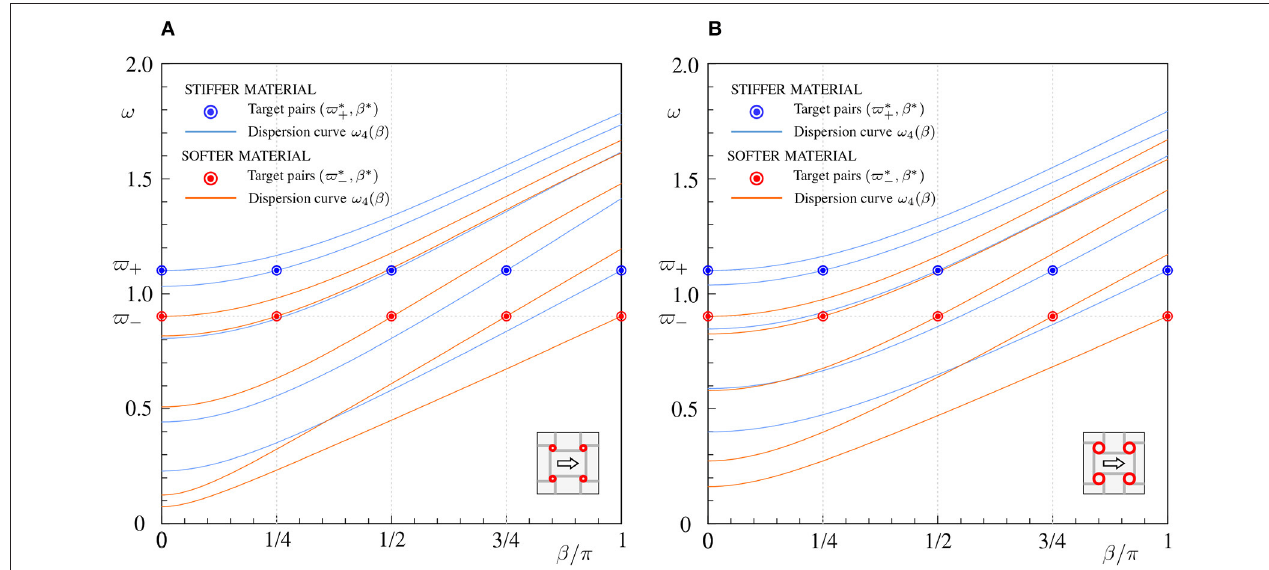
FIGURE 12 | Dispersion spectrum of the anti-tetrachiral material: dispersion curves ω 4 ( β ) designed to include the target frequencies ̟ ∗ ± (for different wavenumbers β ∗ = 0,1 / 4 π ,1 / 2 π ,3 / 4 π , π ): (A) low-density material, (B) high-density material.